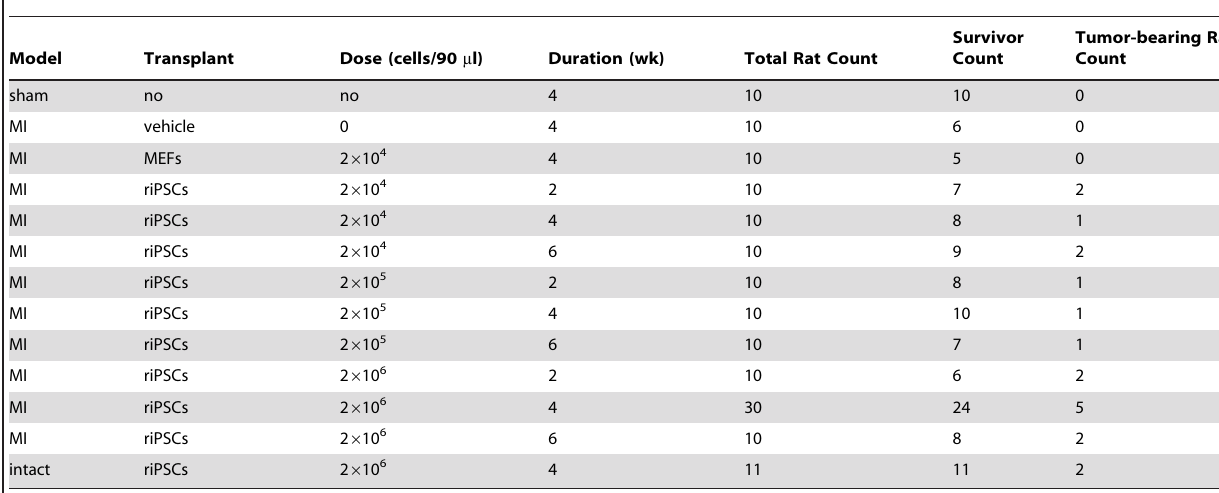
Table 1. Group Information and Tumor